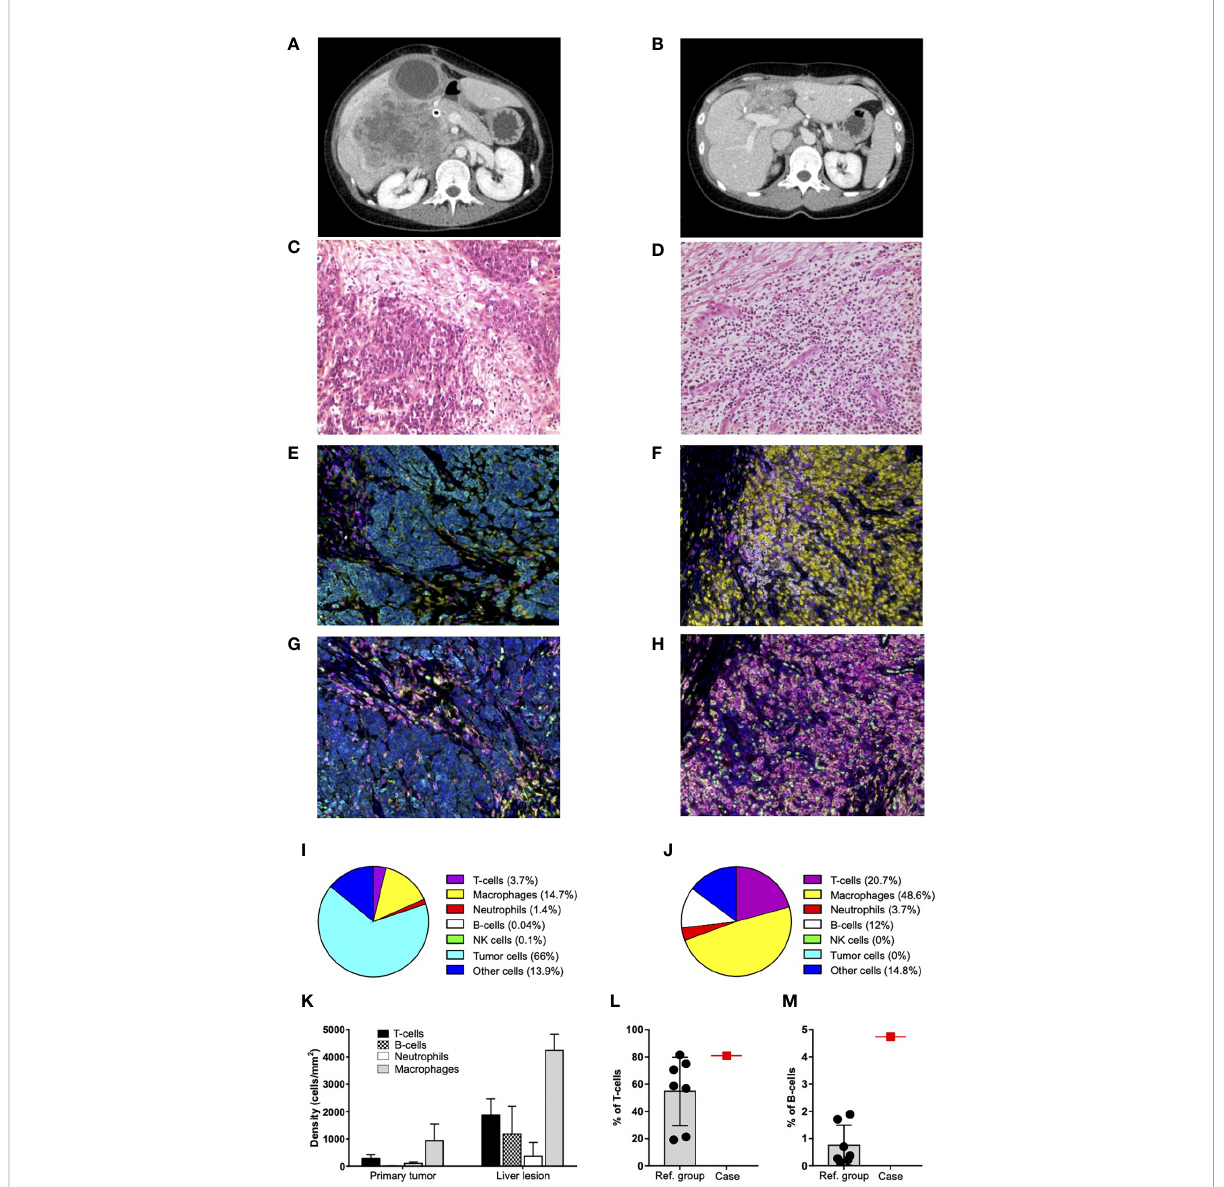
FIGURE 2 Characterization of primary tumor and liver lesion. (A) Re-staging scan before treatment start: large liver metastases in the right lobe associated with a wide abscess in S4. (B) Re-staging CT scan after nine cycles of immunotherapy and surgical resection of residual disease: outcomes of hepatic surgery without any evidence of residual disease. (C) Primary tumor from colonic resection: poorly differentiated adenocarcinoma (hematoxylin and eosin stain at ×200 magni fi cation on light microscopy). (D) Liver lesion after nine cycles of immunotherapy and surgical resection: fi brous scar tissue and fl ogosis, without any evidence of residual neoplastic disease (hematoxylin and eosin stain at ×200 magni fi cation on light microscopy). (E, F) Representative seven-color mIHC images of immune cell in fi ltrates in PT (E) and LL (F) ; staining antibodies of “ panel 1 ” : CD3 (magenta), CD68 (yellow), CD20 (white), CD56 (green), neutrophil elastase (red), pan-cytokeratin (cyan), and nuclei (blue). Original magni fi cation, ×20. (G, H) Representative seven-color mIHC images of myeloid composition of PT (G) and LL (H) ; staining antibodies of “ panel 2 ” : CD68 (magenta), CD11c (red), CD11b (green), CD163 (yellow), neutrophil elastase (white), pan-cytokeratin (cyan), and nuclei (blue). Original magni fi cation, ×20. (I, J) Pie charts of cumulative mIHC data for PT (I) and LL (J) . Data reported for each cell subset are the mean values of 10 fi elds from the same section. The total number of cells analyzed in PT (I) and LL (J) is 24,272 and 35,141, respectively. T cells, macrophages, neutrophils, B cells, natural killer (NK) cells, and tumor cells are identi fi ed as CD3+, CD68+, neutrophil elastase+, CD20+, CD56+, and pan-cytokeratin+ cells, respectively; “ other cells ” refer to cells negative for all these markers. (K) mIHC cell densities (cells/mm 2 ) of immune cells in fi ltrating PT and LL. Mean values and SD derived from the analysis of the same 10 fi elds considered in (I, J) pie charts. (L, M) Percentages of T cells (CD3+) (L) and B cells (CD20+) (M) in fi ltrating fresh liver lesions, as assessed by fl ow cytometry. Patient data (case; red square) are reported together with those from the reference group (Ref. group; black dots). Data are gated on total leukocytes (CD45+). Mean and SD of the reference group are